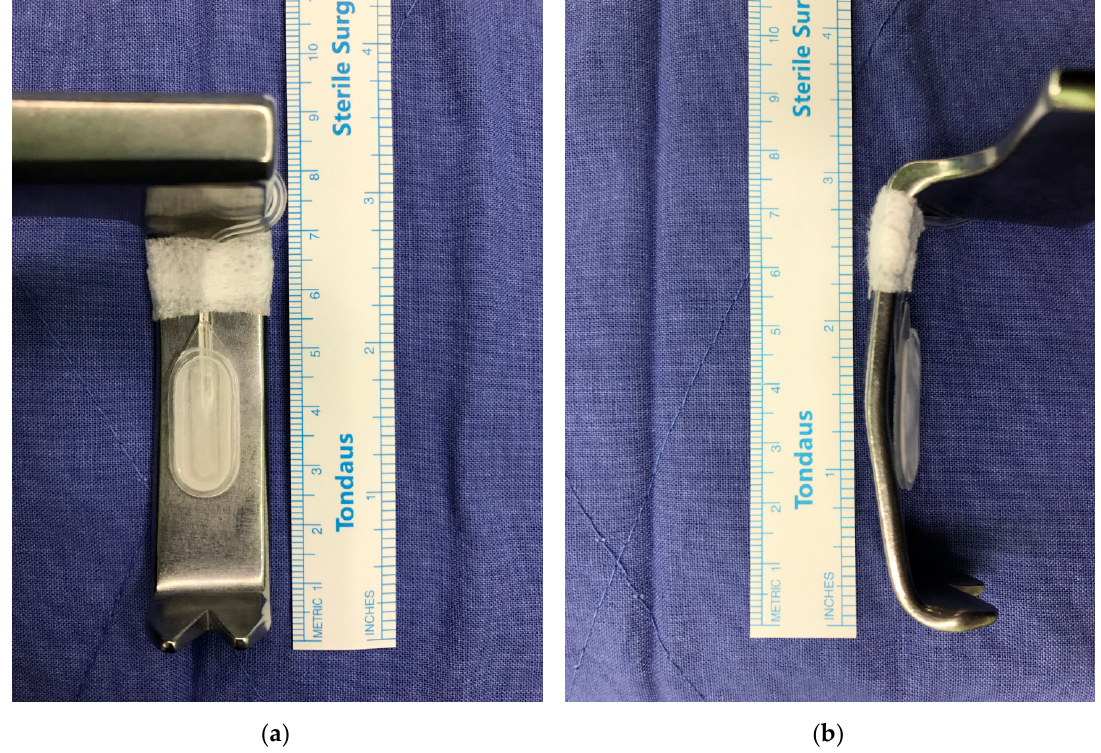
Figure 1. The pressure transducer used for retractor pressure monitoring was attached to a retractor blade. It was mounted on the middle of the inner surface of the retractor. ( a ) Medial view. ( b ) Lateral view.